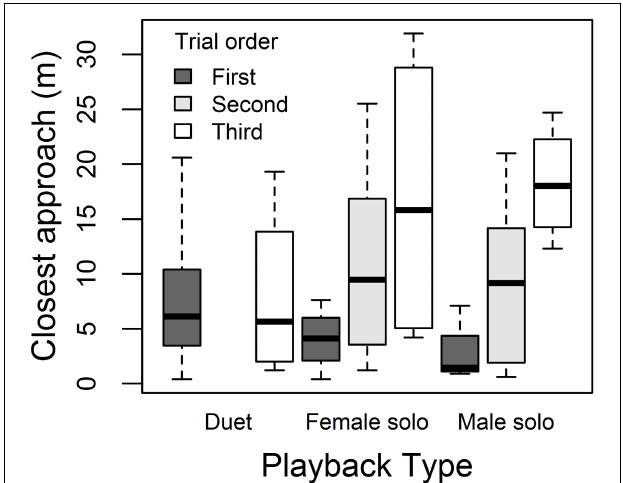
FIGURE 5 | Order effects on male approach. Male closest approach distances to duet, female solo, and male solo playback, depending on whether treatments were presented first (dark gray bars), second (light gray bars) or third (white